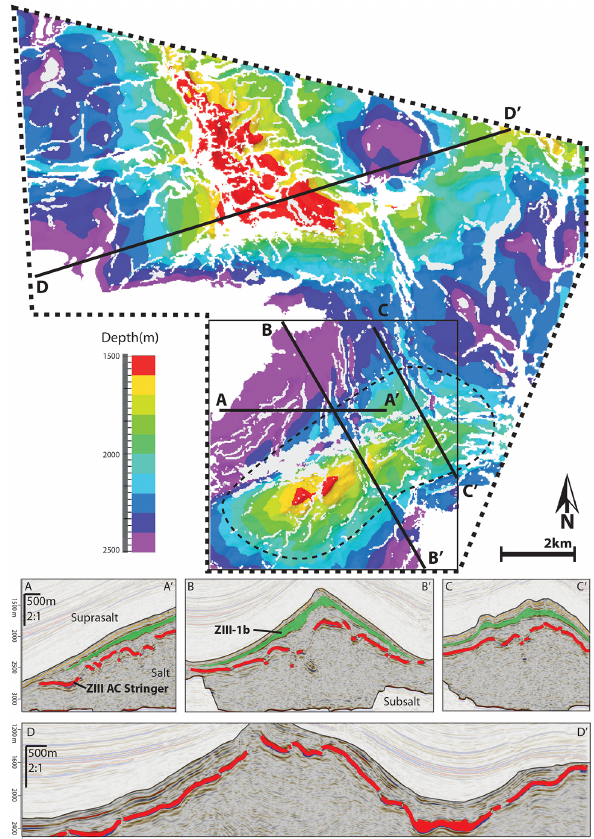
Figure 7. Map view of the ZIII stringer showing the different rup- ture patterns in the two pillows with several profiles. The Veendam Pillow is outlined with the black dashed